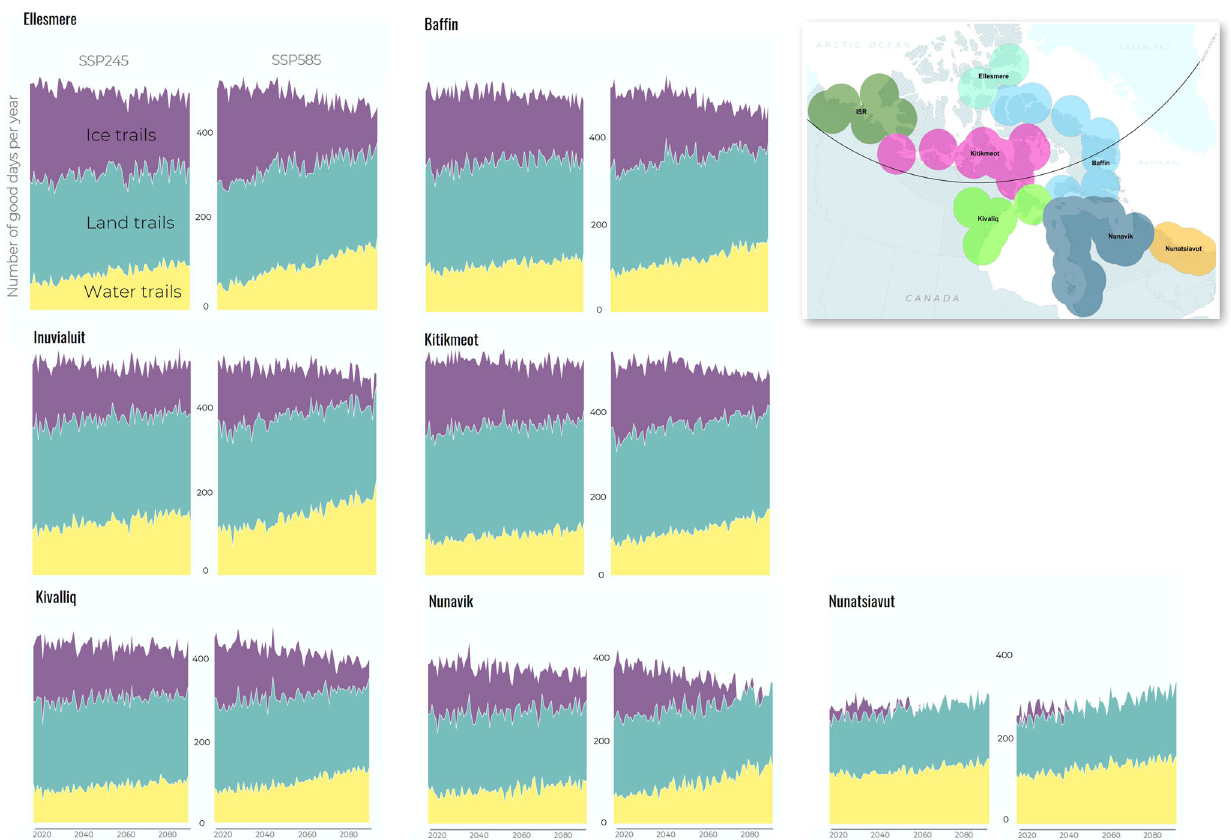
Fig. 4 Regional trends in projected trail access. Calculated for SSP245 and SSP585 emissions scenarios for type 1 trail user by region, 2015 – 2100 (circles around communities capture area covered by projections).